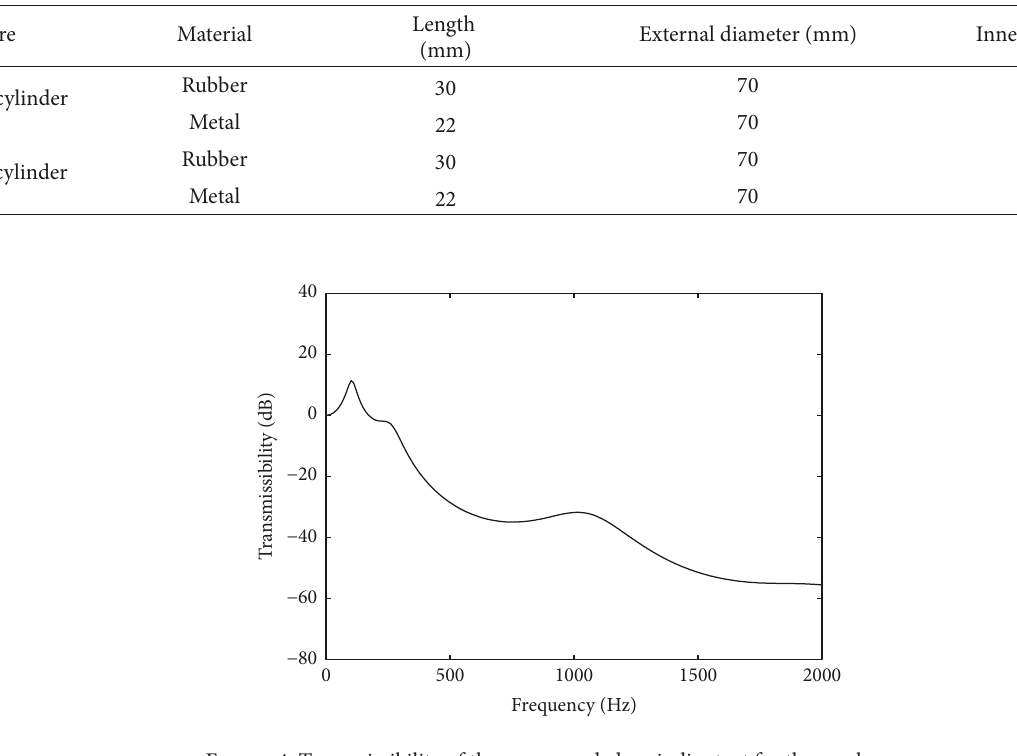
Figure 4: Transmissibility of the compounded periodic strut for the gearbox.